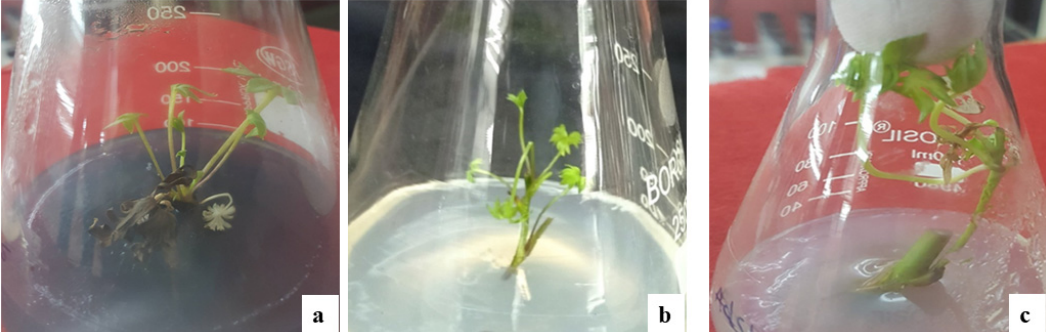
Figure 2. Direct shoot regeneration from nodal explants Aconitum chasmanthum Stapf ex Holmes: ( a ) direct shoot regeneration from nodal explants in MS medium supplemented with BAP (0.5 mg/L); ( b ) direct shoot regeneration from nodal explants in MS medium supplemented with 2,4-D (0.5 mg/L); ( c ) direct shoot regeneration from nodal explants in MS medium supplemented with AdS (10 mg/L).